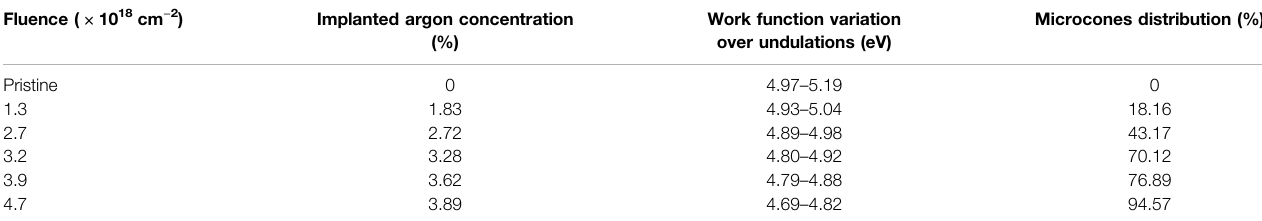
Work function variation over undulations (eV)